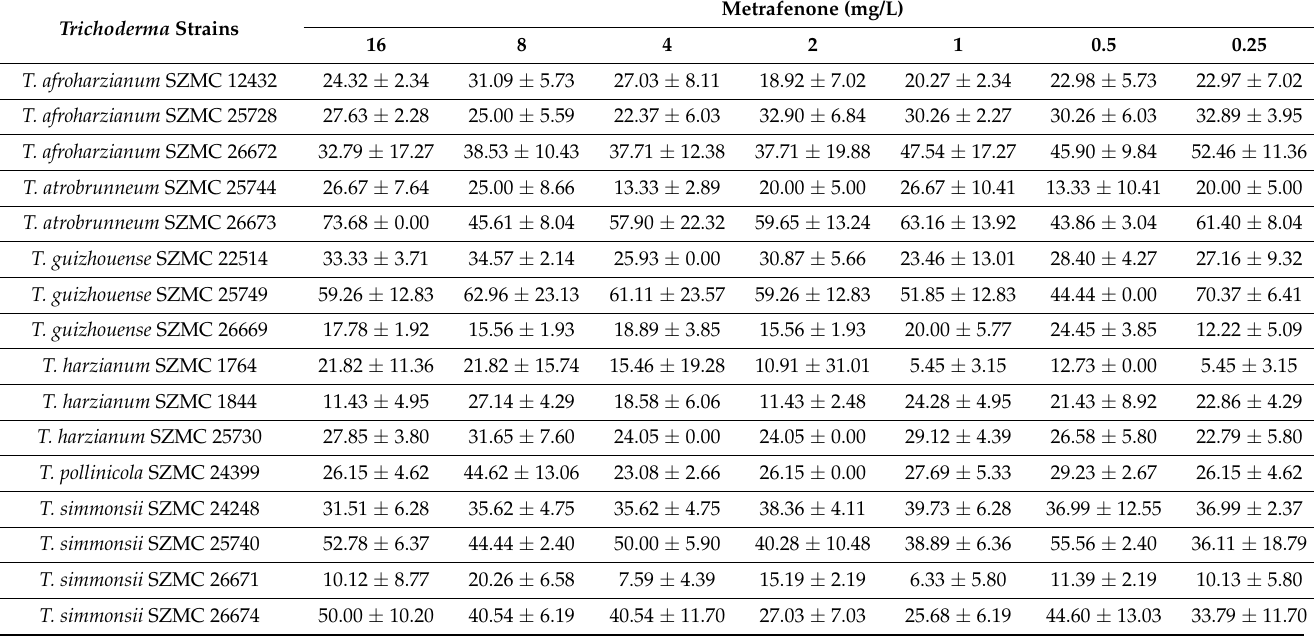
Table 5. Inhibitory effect of metrafenone on the mycelial growth of Trichoderma strains isolated from mushroom production (GI,